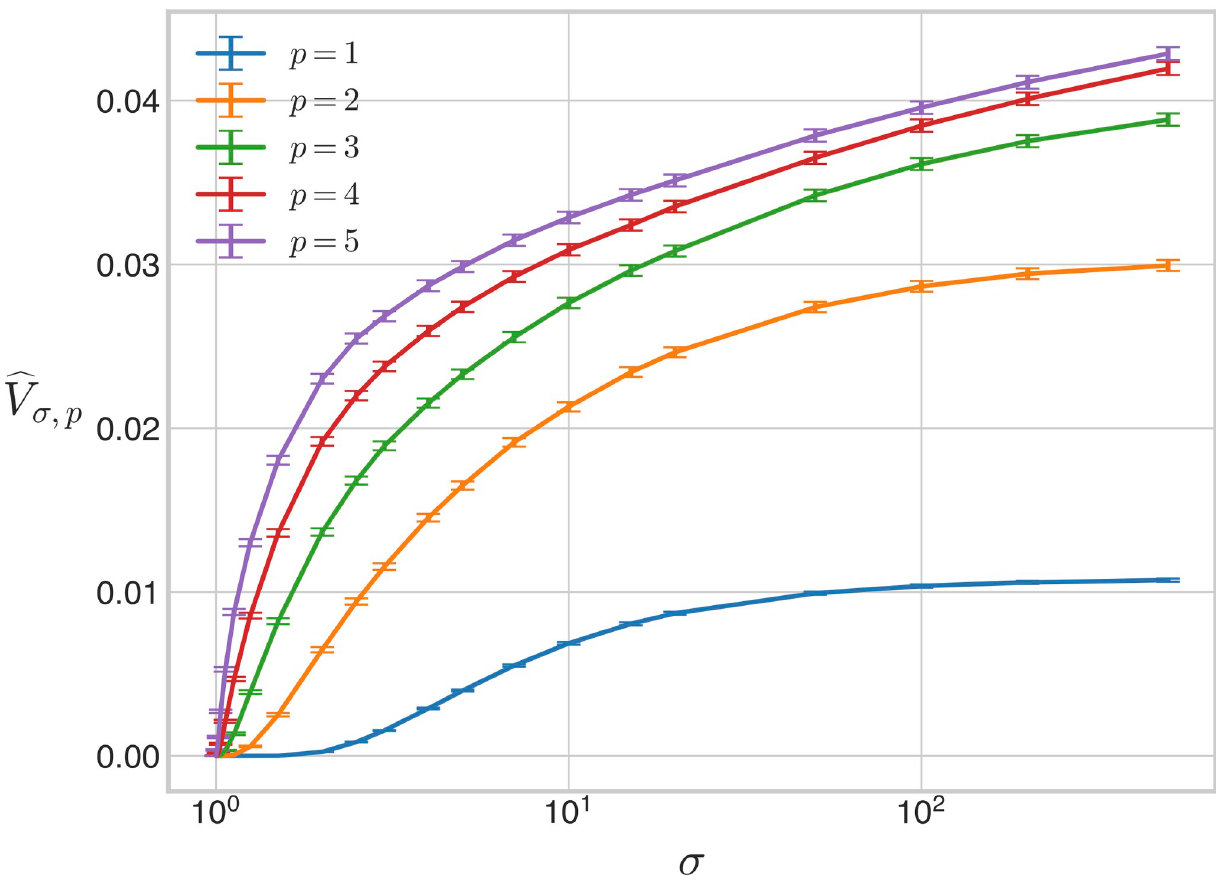
Fig 8. Volume of the bistable region outside H under weak irreversibility. The 8-dimensional volume, b V irreversibility, normalised as a proportion of the volume of the box, H The curve for p = 1 is taken from Fig 3. The error bars give 95% confidence intervals for each estimate (Materials and methods). The estimates have been joined by line segments.